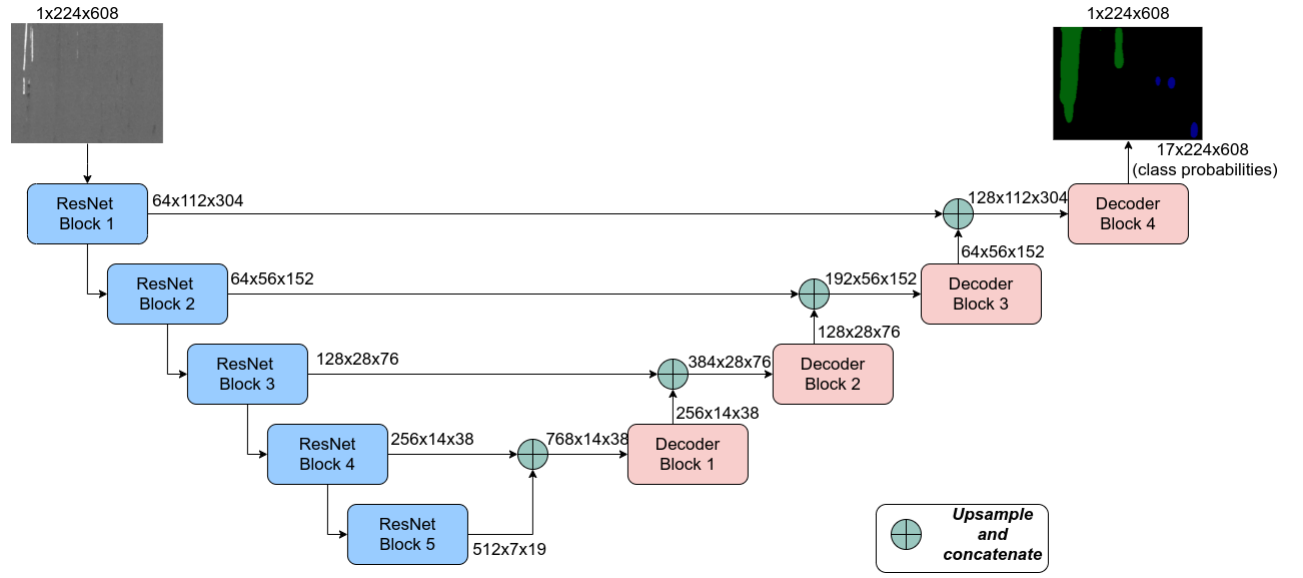
Figure 5. U-Net model [18] with ResNet [19]